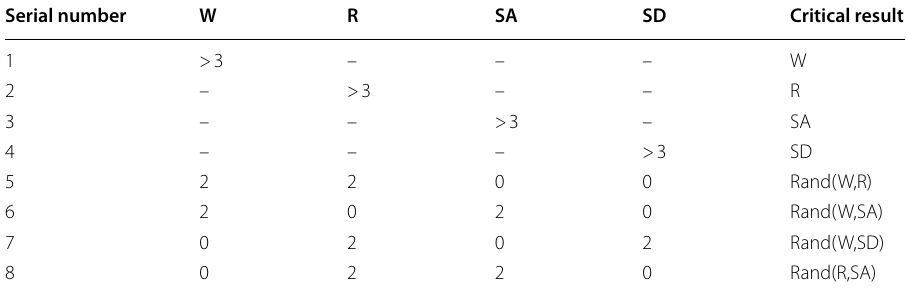
Table 2 Voting decision rules